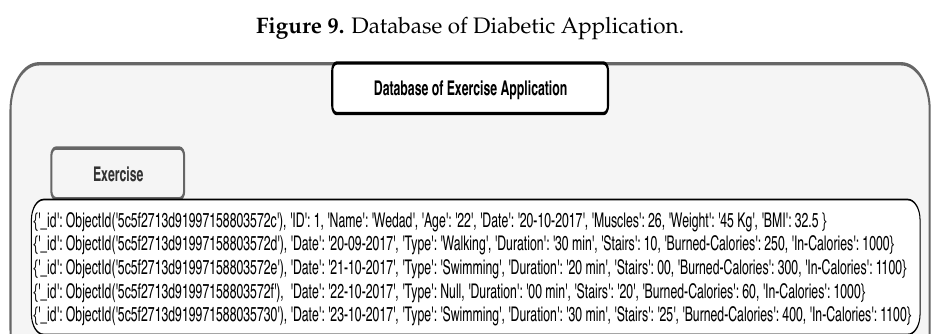
Figure 9. Database of Diabetic Application.